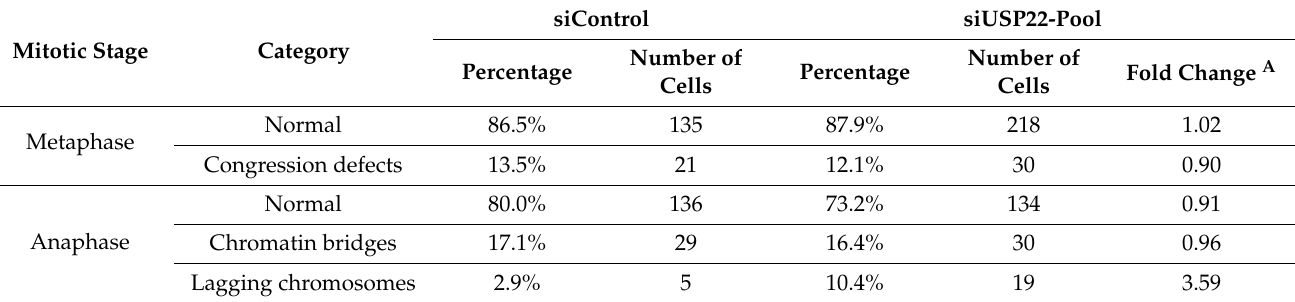
Table 1. USP22 silencing increases the frequency of lagging chromosomes in